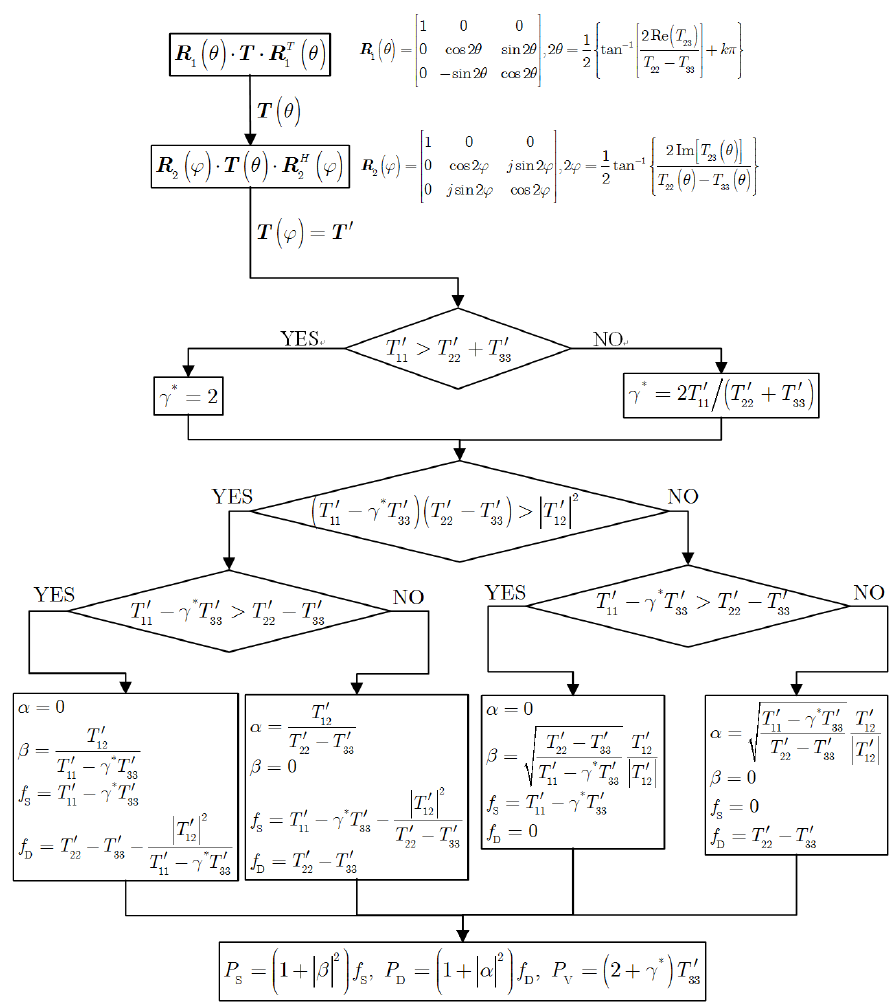
Figure 1. Flowchart of three-component power decomposition with adaptive volume scattering